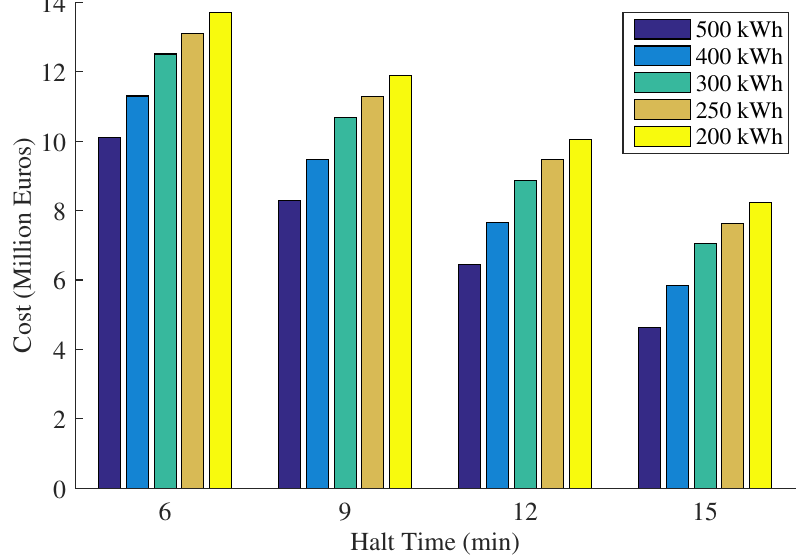
Figure 13. Incurred IPT infrastructure cost with changing halt time at the start of the 40 km